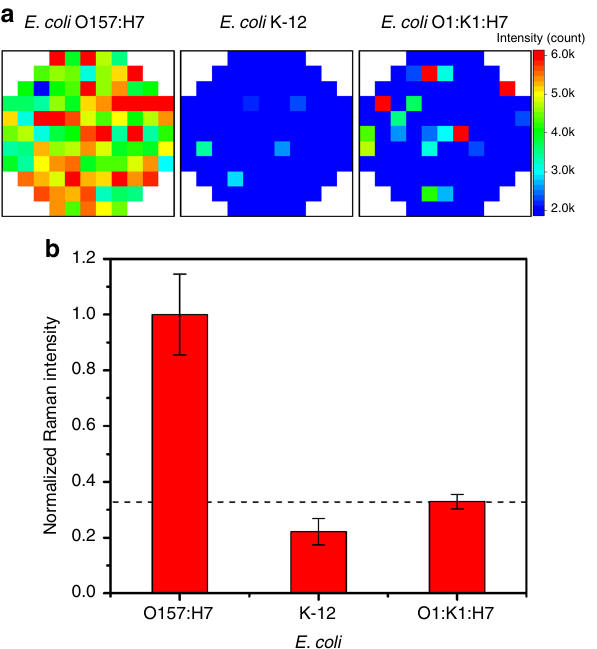
Fig. 6 Recognition selectivity of dex-WS 2 to different strains of E. coli . a Raman images of the dex-WS 2 -treated bacteria based on the 2LA(M) peak of dex-WS 2 at 352 cm − 1 , showing the effective recognition of E. coli O157:H7 against E. coli K-12 and E. coli O1:K1:H7. b The normalized total intensity of the 2LA(M) Raman signal of dex-WS 2 bound on three different strains of E. coli . All error bars represent a standard deviation from